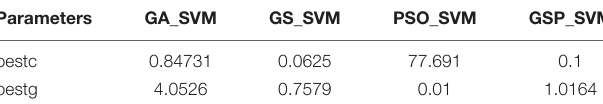
TABLE 5 | The optimal parameters of algorithms.